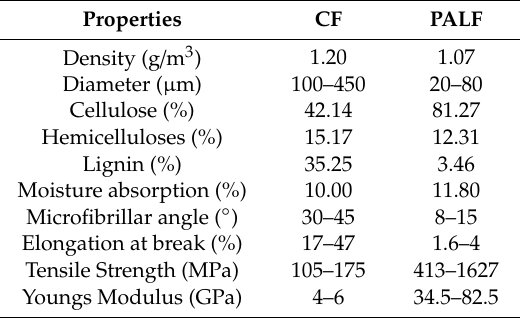
Table 2. Properties of coir fibres (CF) and pineapple leaf fibres (PALF)